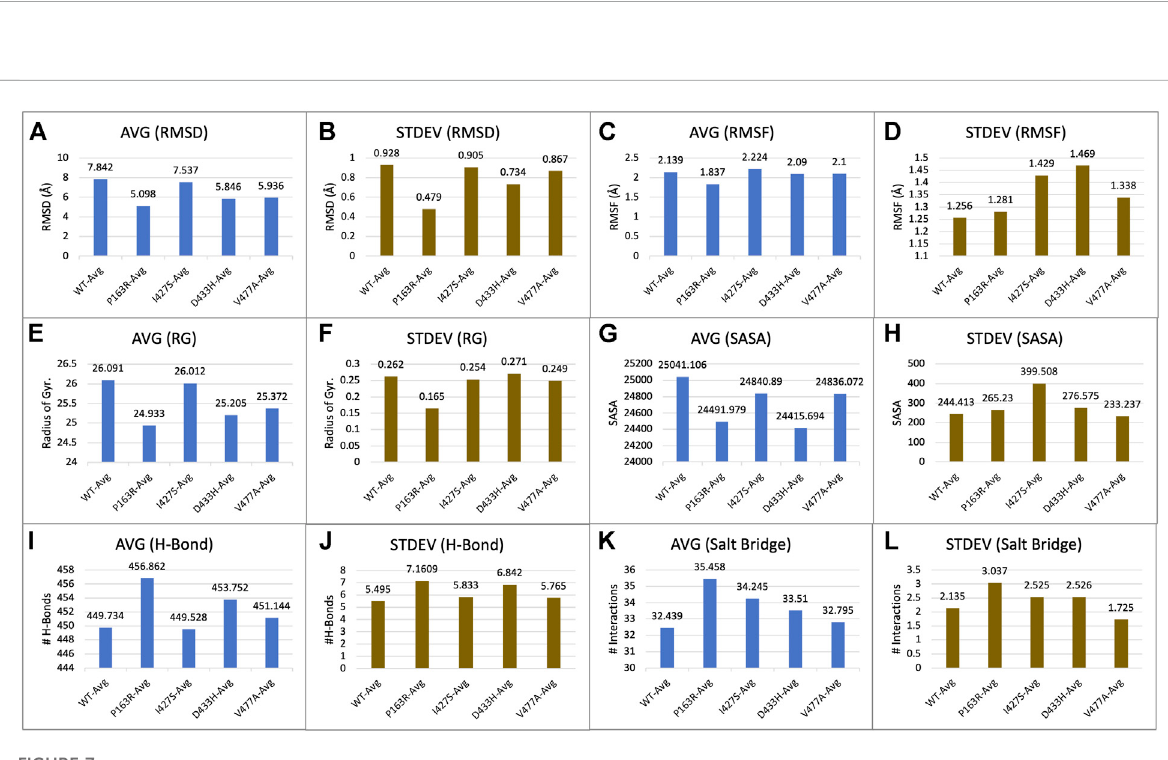
FIGURE 7 StatisticalmeasureanalyzedusingMDsimulationresults. PlotsshowingtriplicateaverageandstandarddeviationsofRMSD,RMSF,Rg,SASA,H- bonds,andSaltbridgescalculationsforWTandmutants. (A) AverageRMSD, (B) StandarddeviationinRMSD, (C) AverageRMSF, (D) Standarddeviation in RMSF, (E) Average Rg, (F) Standard deviation in Rg, (G) Average SASA, (H) Standard deviation in SASA, (I) Average h-bond interactions, (J)